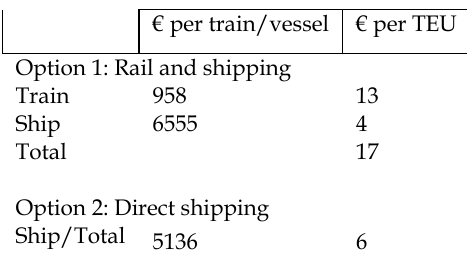
Internalization fees for the two options € per train/vessel € per